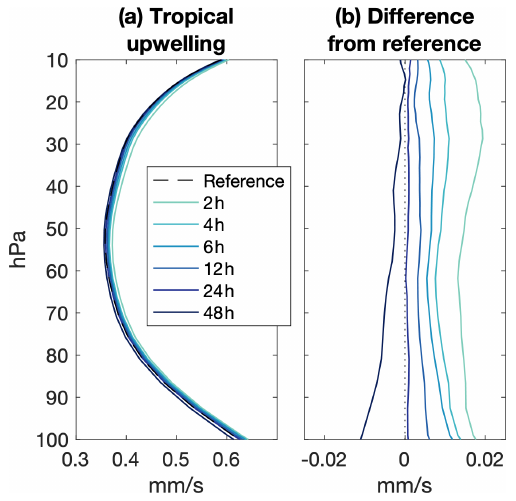
Figure 6. Tropical stratospheric upwelling (a) mean and (b) differ- ence from the reference meteorology for all nudging timescales at 24 meteorology updates per day. Tropical stratospheric upwelling is defined as the area average of all annual mean upwelling vertical velocities at each vertical